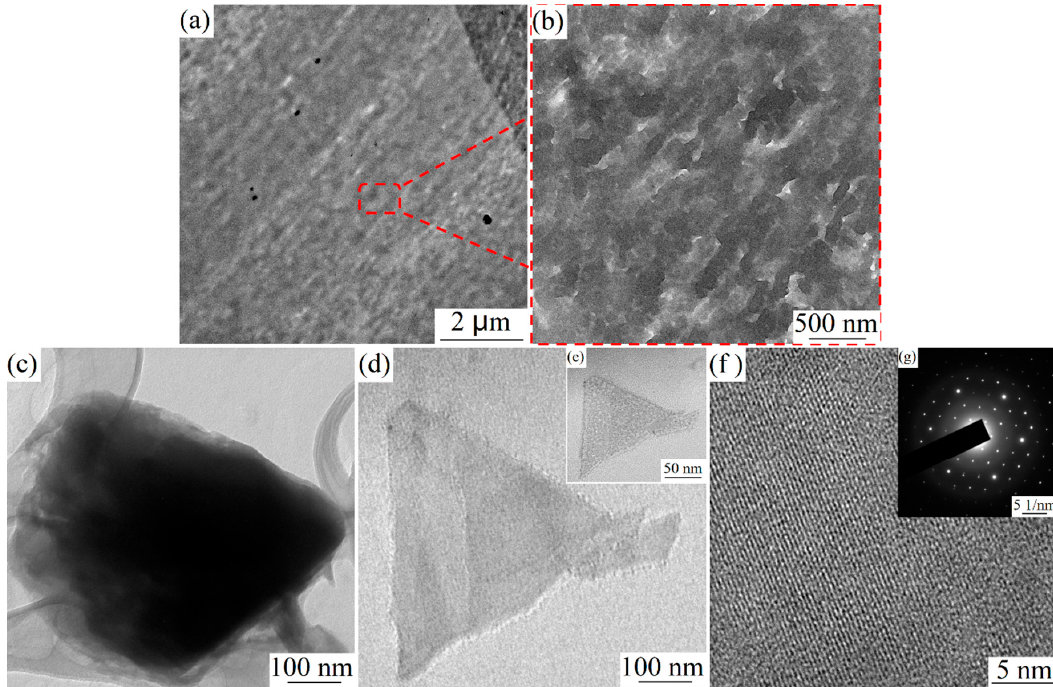
Figure 4. TEM images of ( a , b ) 50% PDLA/PLLA blends, ( c – e ) SC lamellar crystals, and ( f , g ) corresponding electron diffraction patterns of stereocomplex (SC) crystals.